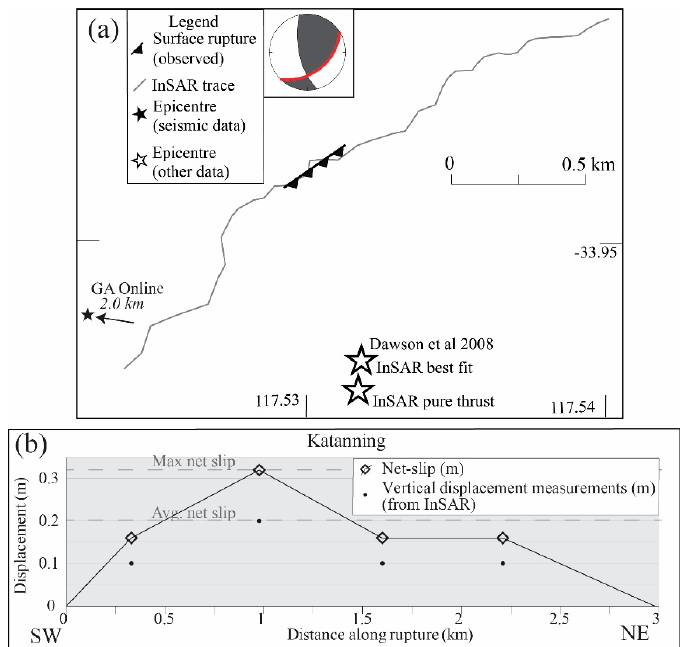
Figure 8. 2008 Mw 4.7 Katanning earthquake ( a ) approximate visible rupture and InSAR trace (digitized from [70]), published epicenter locations and focal mechanism [70] ( b ) graph of along-rupture vertical and displacement taken from InSAR data [70] and net slip calculated from InSAR data (this study).